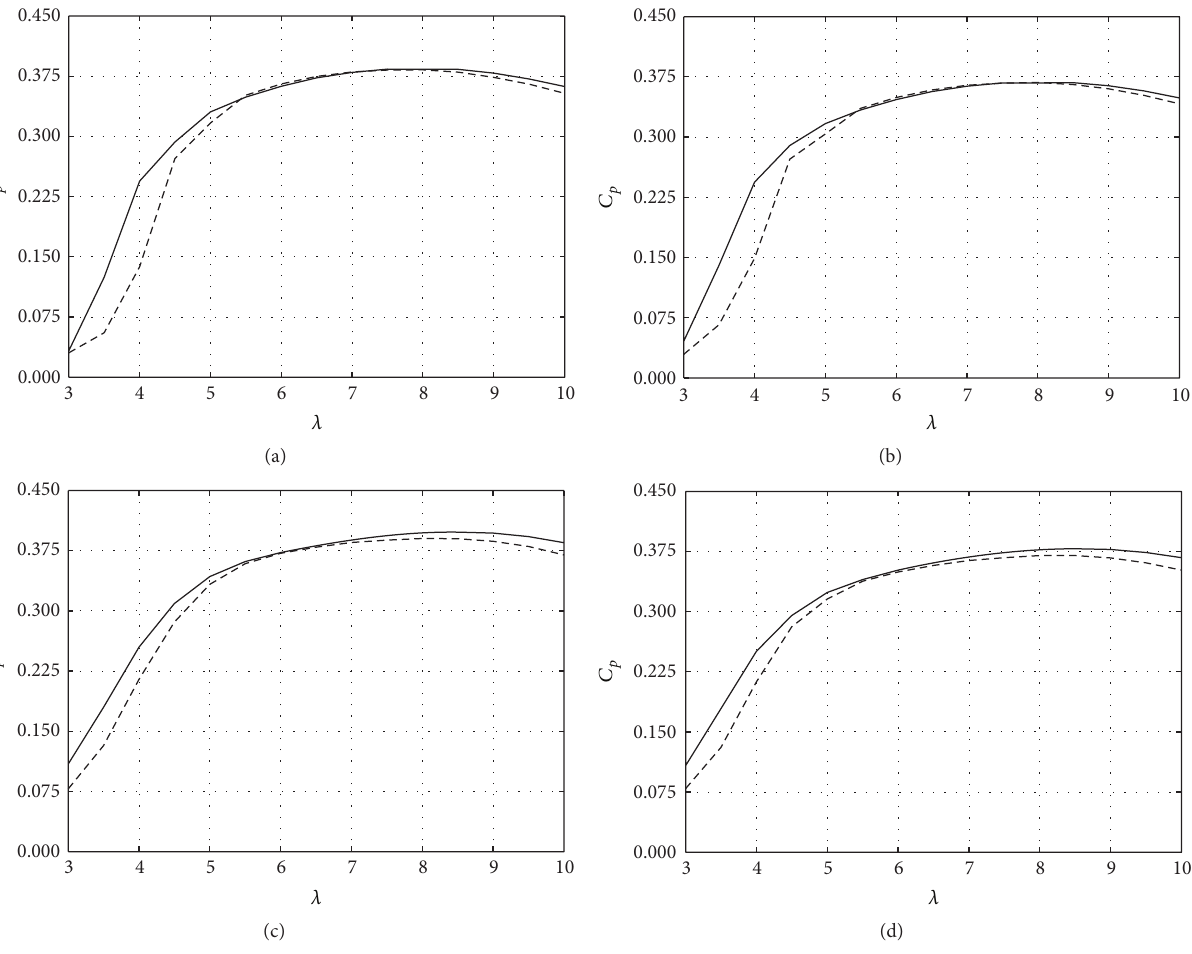
Figure 7: 𝐶 𝑝 versus 𝜆 for 𝑈 ∞ = 11.1 m/s (solid line) and 𝑈 ∞ = 7.3 m/s (dashed line). Model input: (a) 𝑁 crit = 7 , AERODAS, tip loss model on; (b) 𝑁 crit = 7 , AERODAS, tip loss model off; (c) 𝑁 crit = 7 , Viterna, tip loss model on; (d) 𝑁 crit = 7 , Viterna, tip loss model